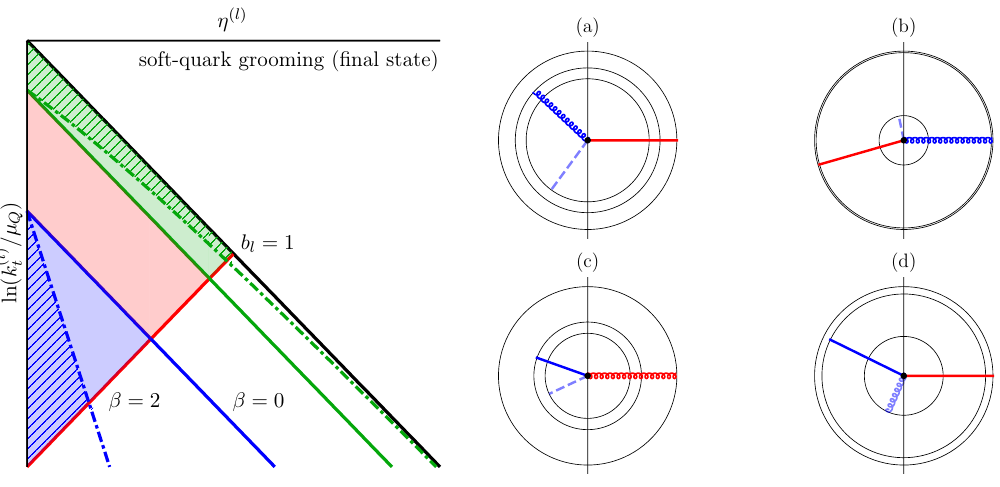
Figure 6 . Left: the emission phase space in the Lund plane with the C AESAR parameters a l = 1 and b l = 1 (valid for thrust). The green area marks the phase-space region where the emitting particle will be removed by grooming with boundaries corresponding to β = 0 (solid line and area) and β = 2 (dashed line, hatched area). The blue area marks the region where the emitted gluon is removed, cf. figure 3. Right: displays of the transverse plane of several LO final-state configurations. The colour codes indicate jet association according to the BSZ algorithm, groomed particles are in light shade and dashed in the case of quarks. (a) Sample event from the green area, where the quark is groomed instead of the gluon. (b), (c) Sample events with two quarks in one hemisphere, with the softer one getting groomed, for different jet clusterings. (d) Sample event from the blue area, a soft gluon is